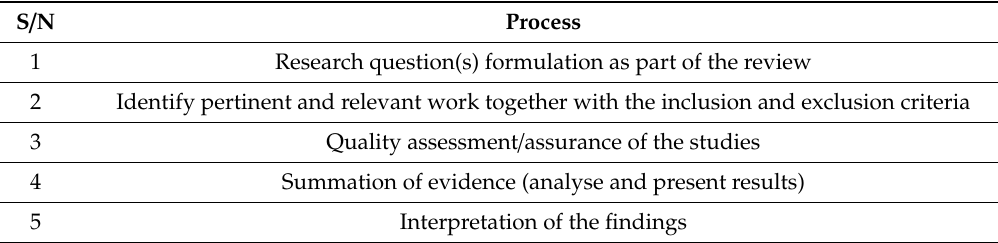
Table 6. The systematic review process